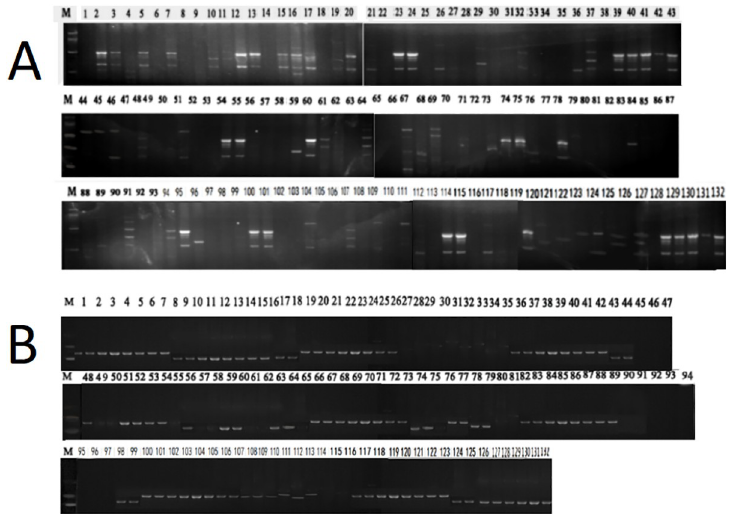
Fig 2. Two electrophoretograms of SSR gel. (A) Vica10/154 (B) Vitg9/99.